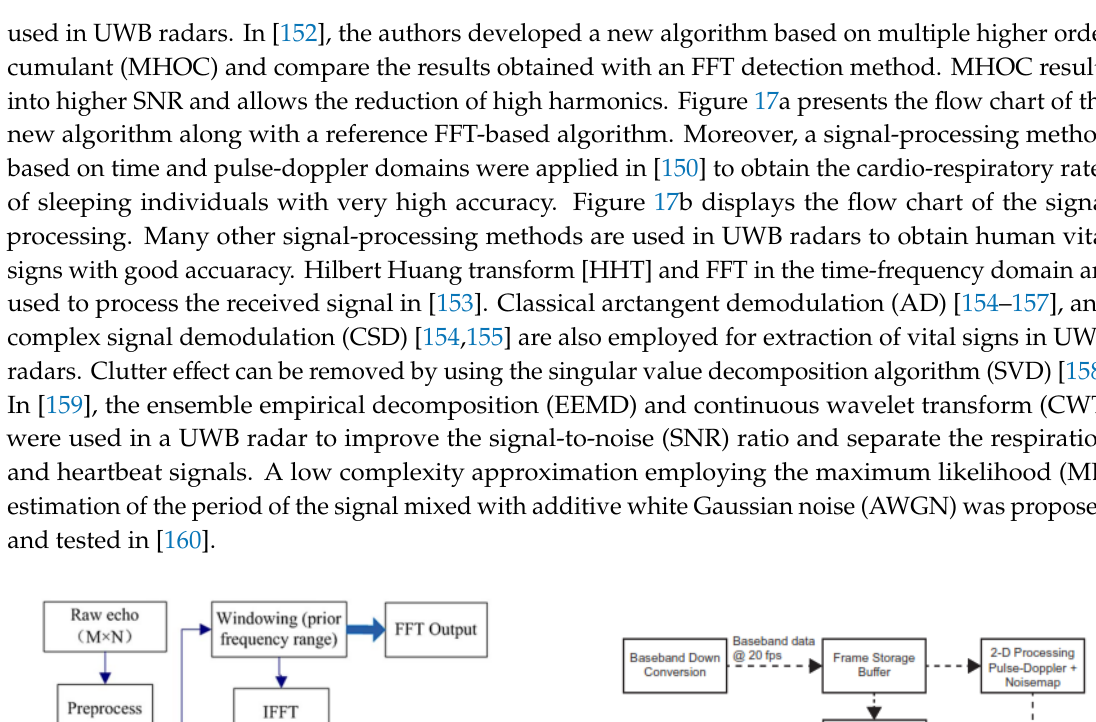
Figure 18. Federal Communication Commission (FCC) and European Electronic Communication Commission (ECC) masks for UWB application [166]. Table 2. Comparison of Radar-Based Vital Signs Monitoring Systems.